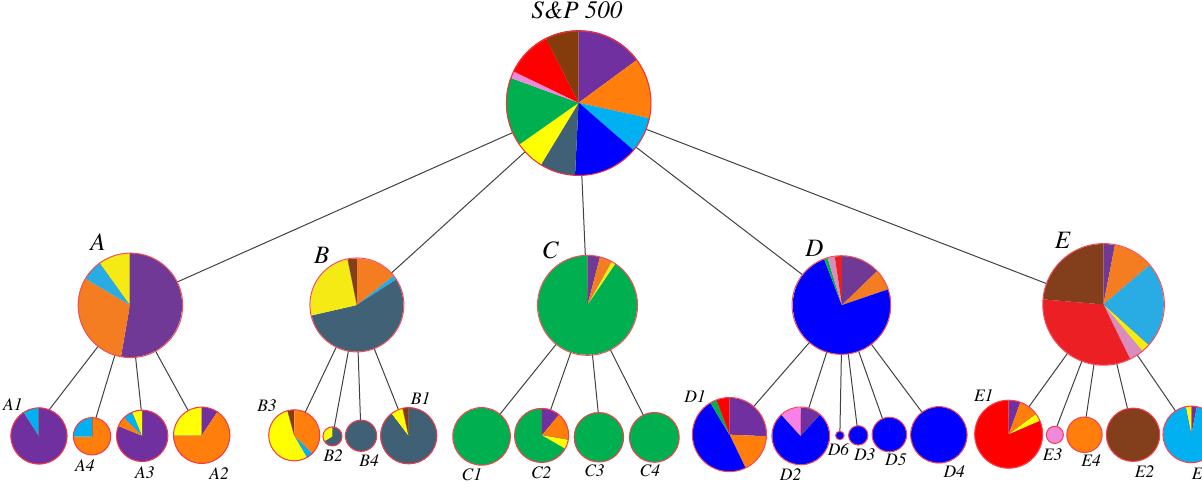
FIG. 12. Multiresolution community detection reveals the hierarchical structure of the communities of the S&P 500 (from cross- correlations of log-returns of daily closing prices from 2001Q4 to 2011Q3). The dendrogram gives an alternative, combined representation of Figs. 6, 7 and 11. (The modified Louvain algorithm has been